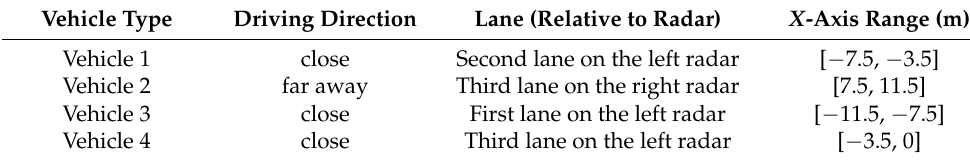
Table 3. Vehicle information.